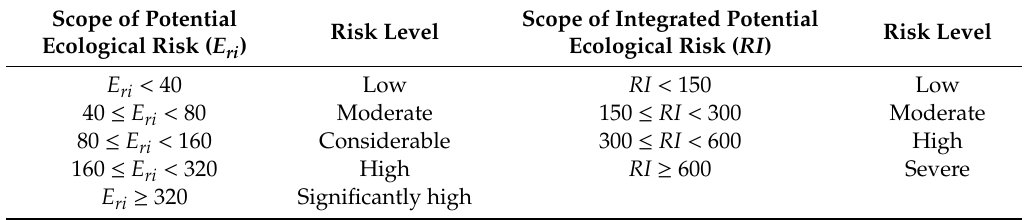
Table 5. Classification of the potential ecological risk index and integrated potential ecological risk index.